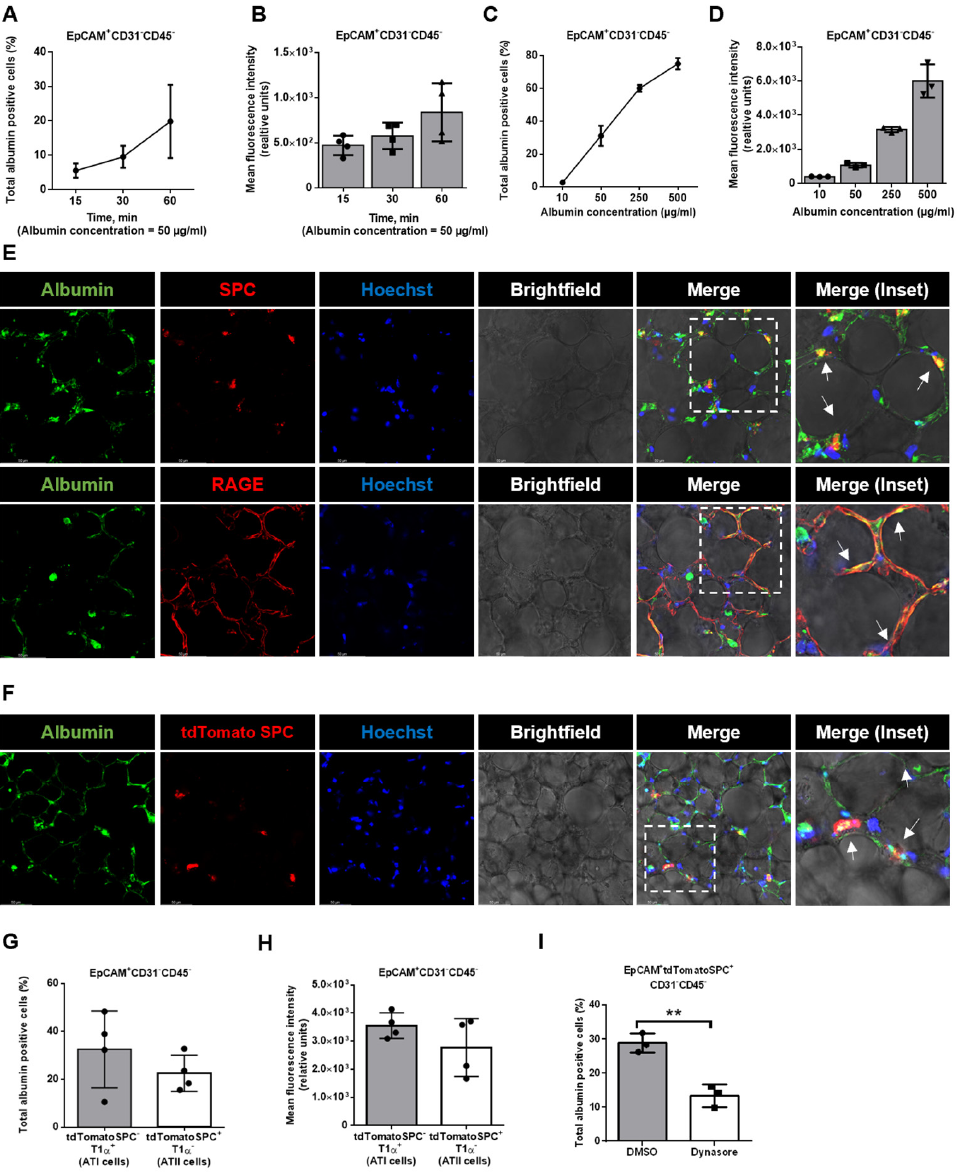
Figure 4. Alveolar epithelial albumin uptake in PCLS: ( A , C ) Murine PCLS were treated for different durations and with various concentrations of AlexaFluor488 − albumin and subsequently the amount of albumin-positive epithelial cells (EpCAM + CD31 − CD45 − ) was analyzed by FC ( n = 3).